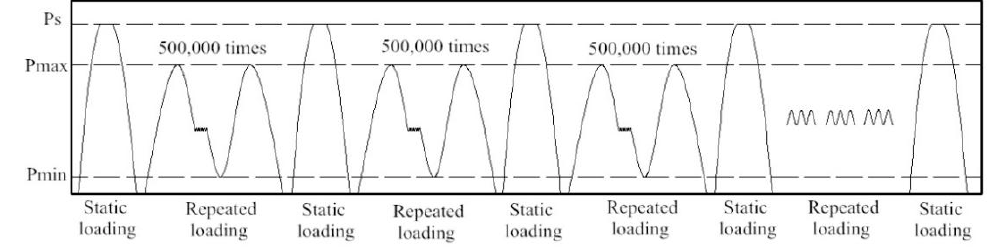
Figure 11. Procedure of the fatigue tests.